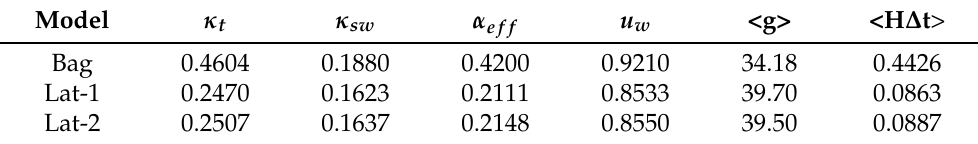
Table 3. Parameters of the gravitational wave spectrum.